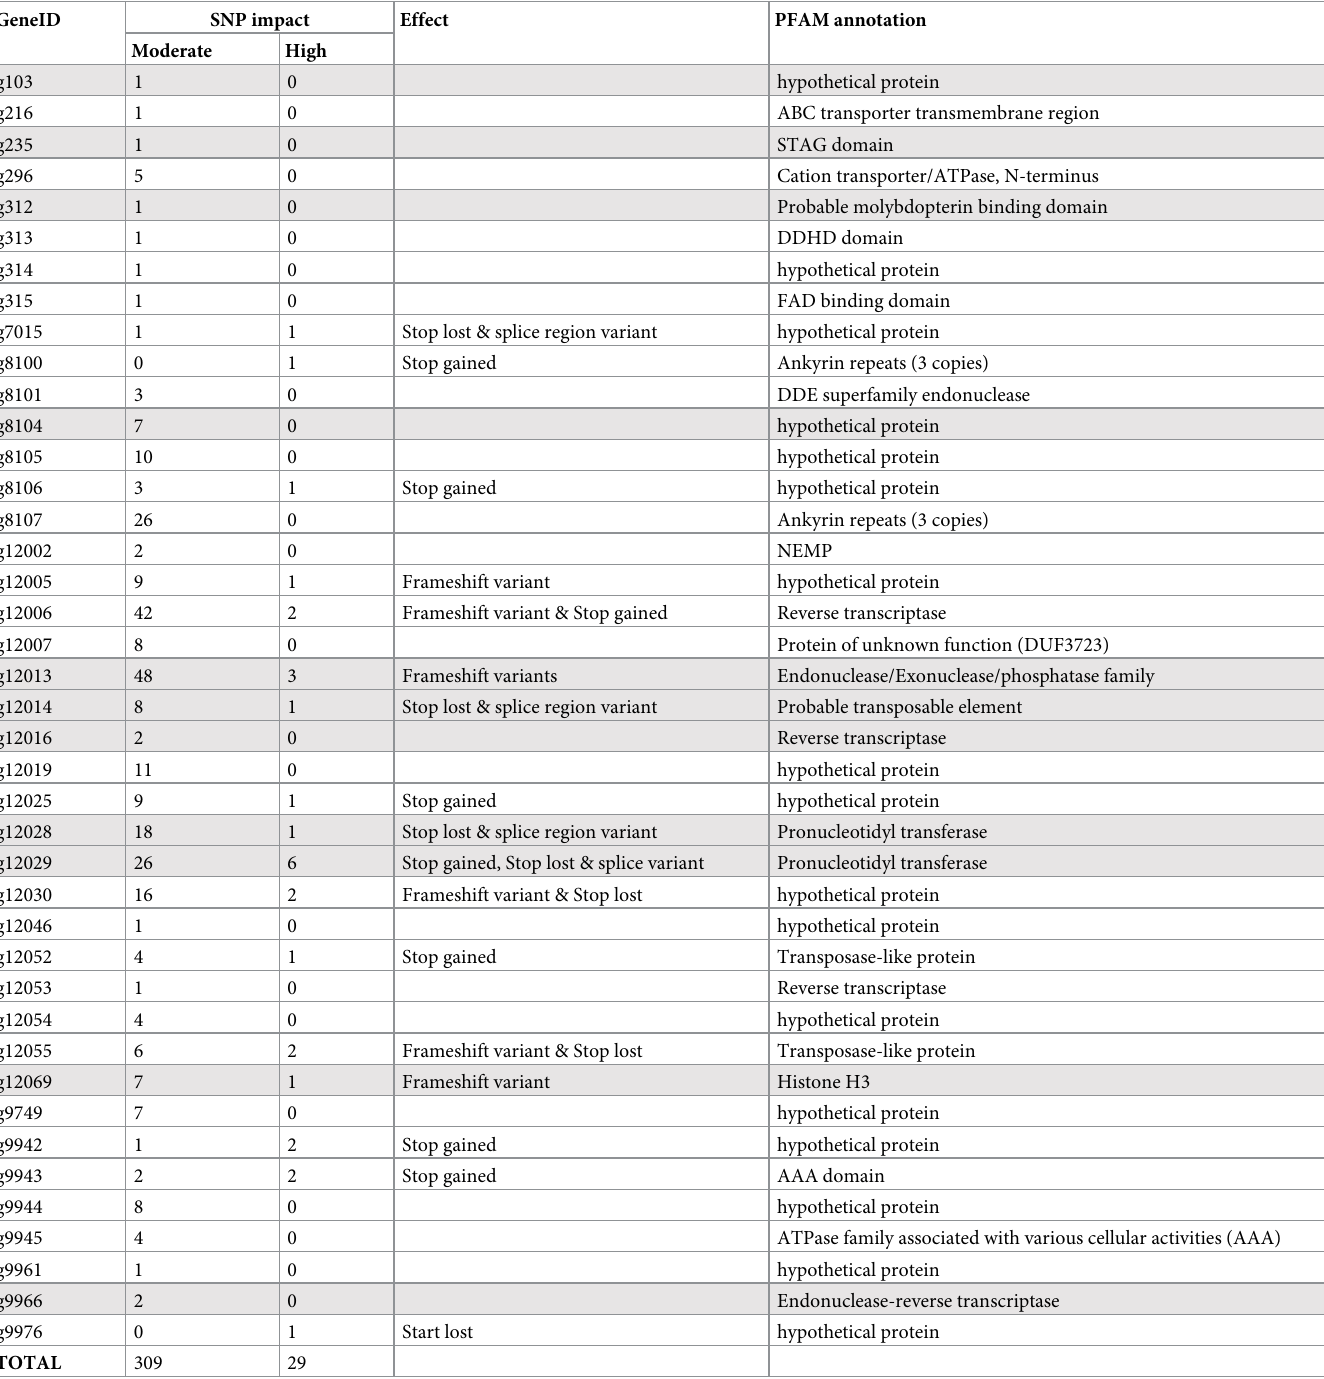
Table 3. Genes (DTO006G7) containing SNPs associated with sorbic acid resistance. Only SNPs with a − log 10 (p-value) > 5 and a moderate or high impact as deter- mined by SNPeff are listed. Grey shading indicates overlap with sequence